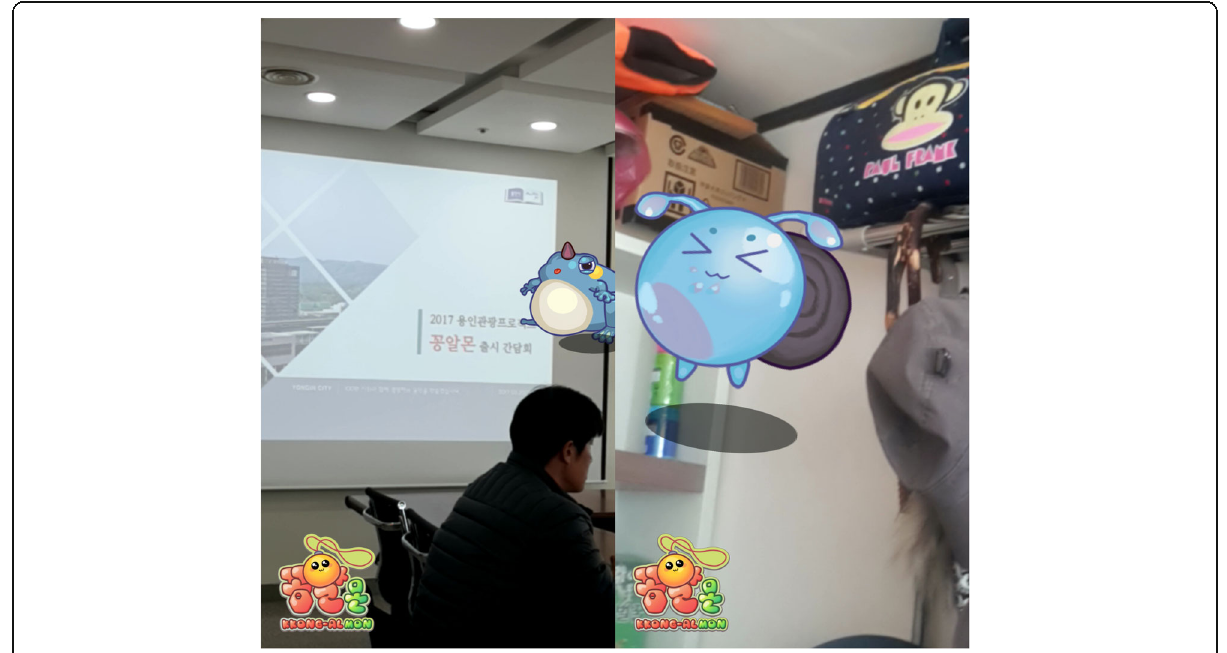
Fig. 6 Example of using gyroscope sensor. An example of using gyroscope sensor of the Kkongalmon